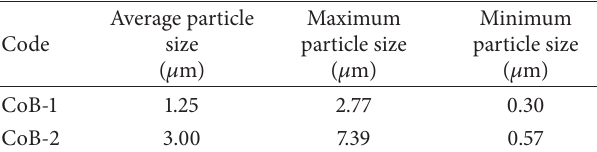
Table 2: Particle size distribution of Co-B catalysts. Code